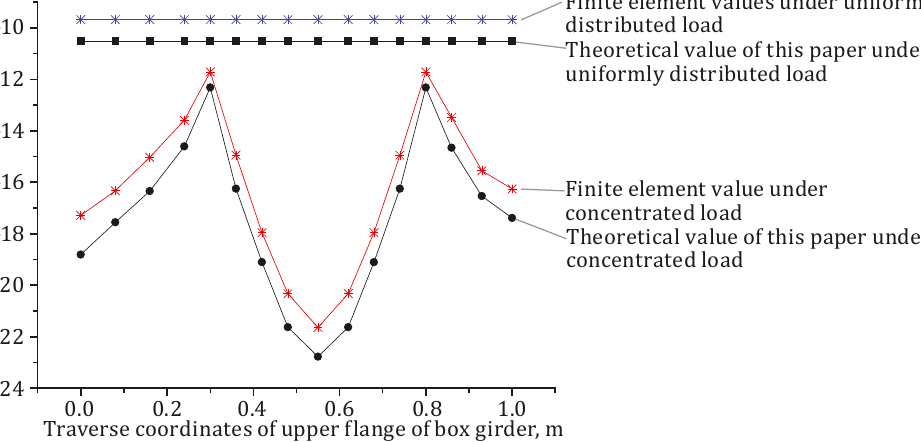
1.0 Figure 11. Accordion effect of upper flange